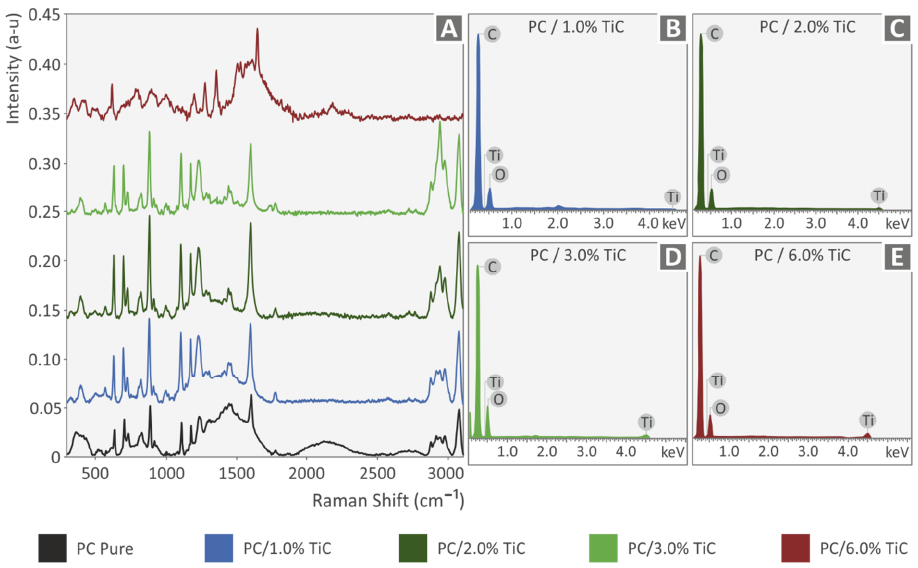
Figure 5. ( A ) Raman spectra for all materials tested, ( B ) EDS graph for PC/TiC 1 wt.%, ( C ) EDS graph for PC/TiC 2 wt.%, ( D ) EDS graph for PC/TiC 3 wt.%, and ( E ) EDS graph for PC/TiC 6 wt.%.